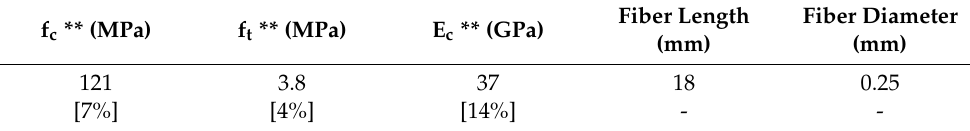
Table 2. Summary of the main properties of HPFRC *.